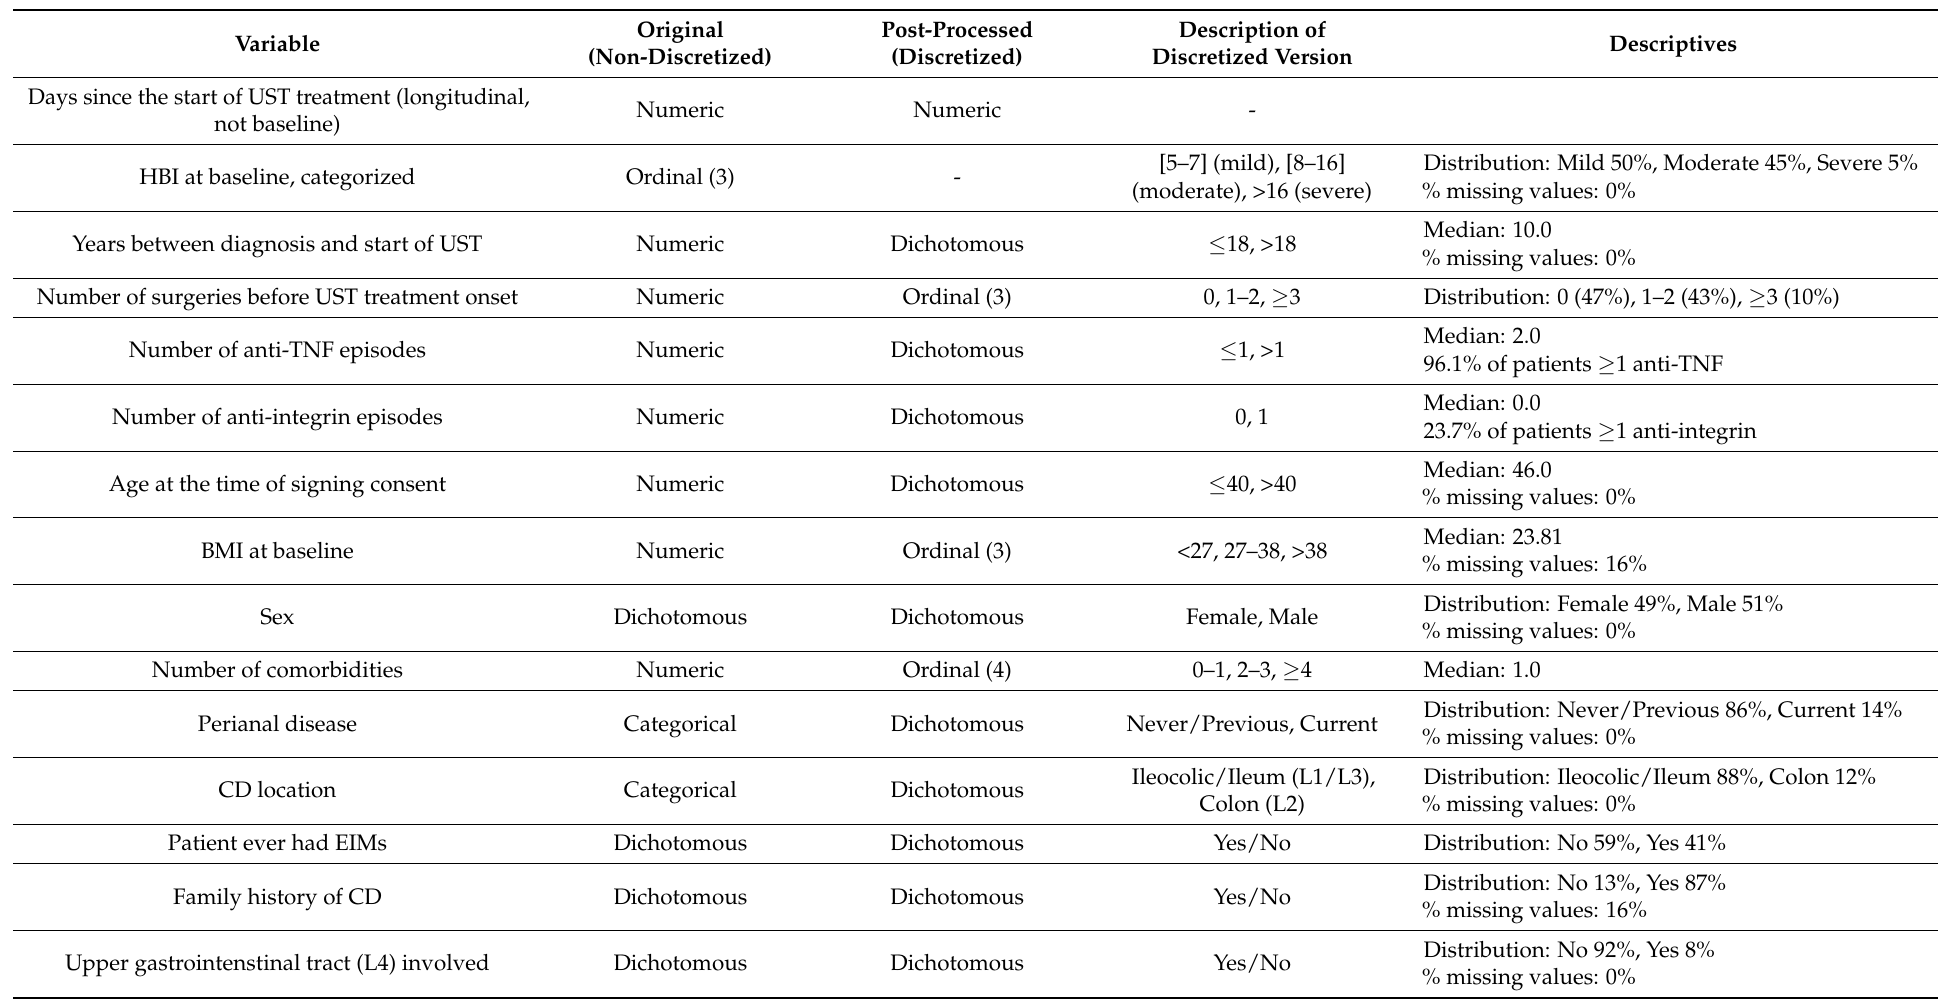
Table 1. Variables employed in their original form and